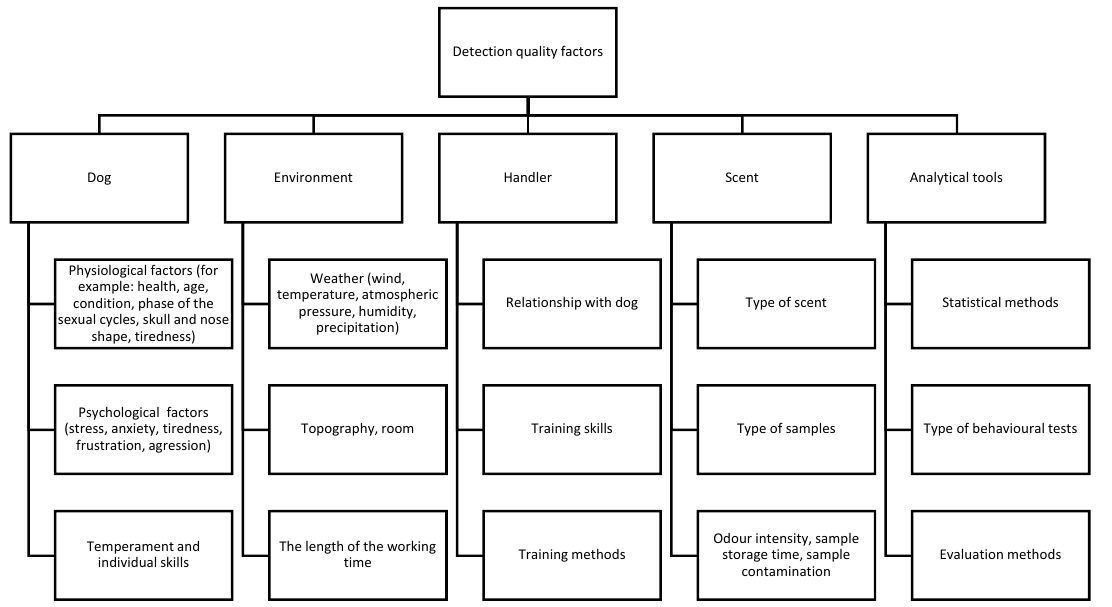
Figure 2. Factors affecting the efficiency of canine olfactory detection.